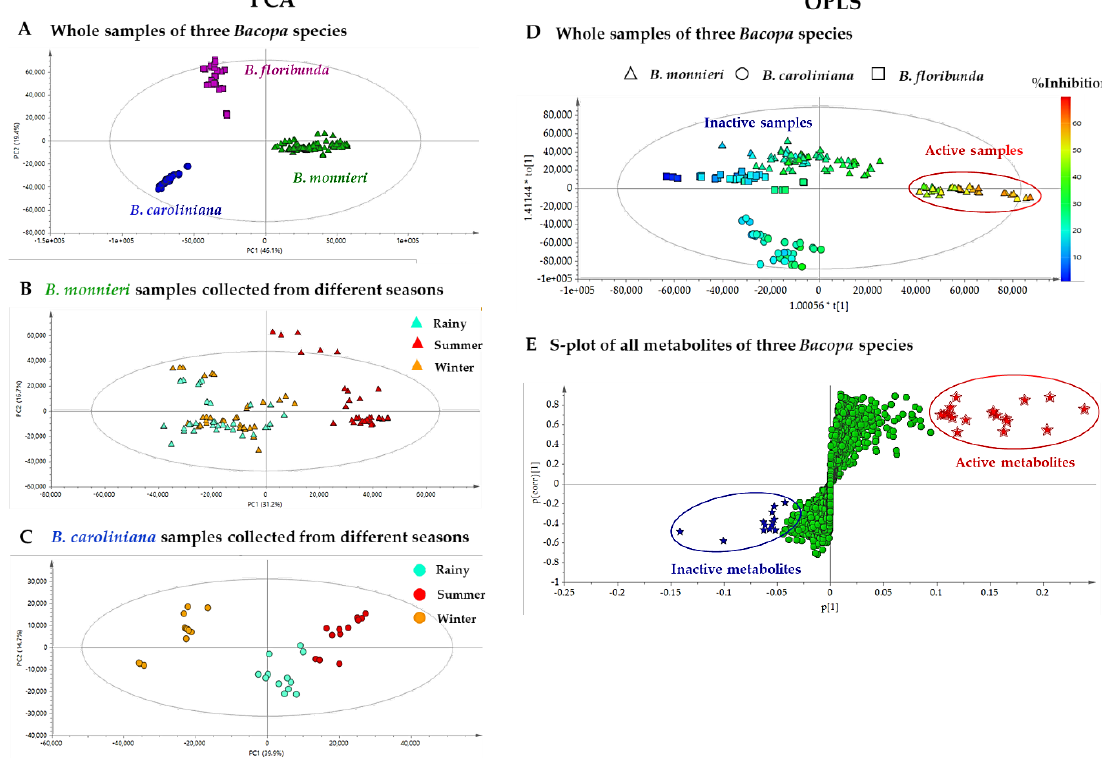
Figure 3. ( A ) PCA score plot based on chemical profiles of 59 extracts of three Bacopa species . ( B ) and ( C ) PCA score plots based on chemical profiles of 36 extracts of B . monnieri and 12 extracts of B . caroliniana , respectively from different sources in three seasonal collections . ( D ) OPLS score plot based on the chemical profiles and anti - lipid peroxidation activity of all Bacopa extracts . ( E ). S - plot presenting nineteen candidate active features with high p [ 1 ] values ( red filled star ) and inactive features with low p [ 1 ] value ( blue filled star ).